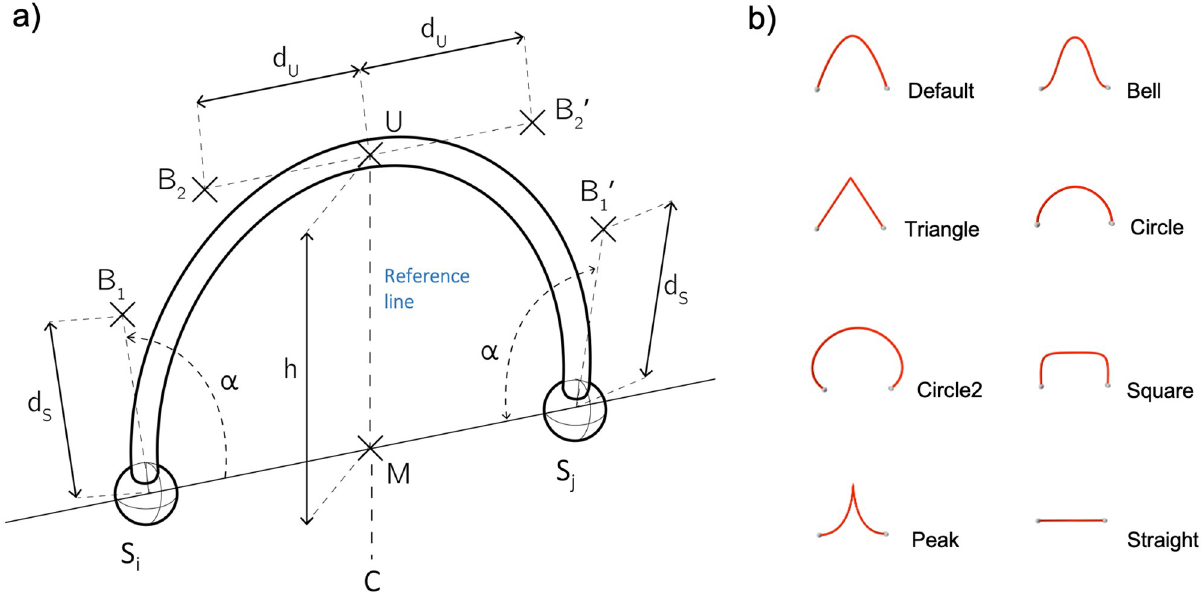
Fig 1. Geometric principles for shaping links. a) Schematic illustration of the parameters controlling the shape of the link between two nodes S i and S j . The reference point M lies on the geodesic distance d between the nodes. Bezier boundary points are referred as to B and can be moved by modulating i j four quantities, i.e., h , d , α and d . Note that the angles d B and d B 2 0 UM are always square and not customizable for the sake of simplicity. b) Typical U S 2 UM configurations that can be obtained with different combinations of the controlling parameters a 1 , a 2 , a 3 , a 4 in the GUI. Default (0.75, 0.5, 0.38, 0), Bell (0.75, 0.5, 0, 0.5), Triangle (0.75, 0, 0, 0), Circle (0.5, 0.5, 0.5, 0.5), Circle2 (0.9, 1, 0.8, 1), Square (0.5, 1, 0.5, 1), Peak (0.75, 0, 0, 1), Straight (0, 0, 0, 0).